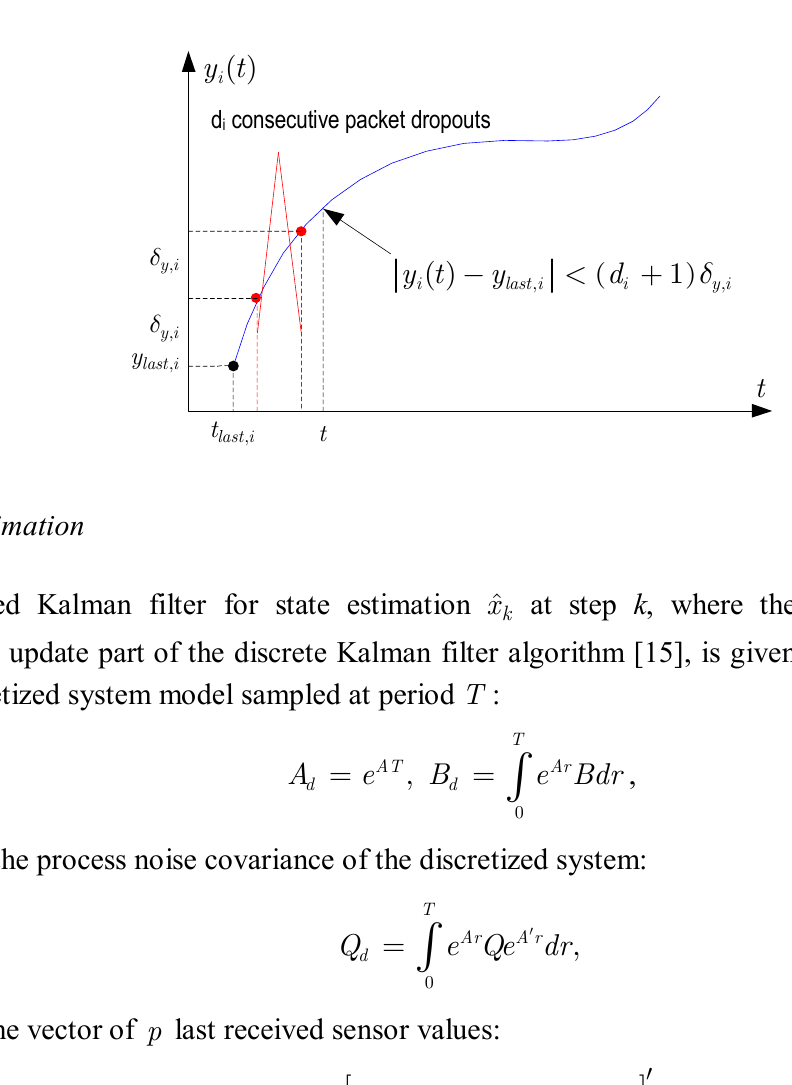
Figure 3. Measurement noise increased due to multiple packet